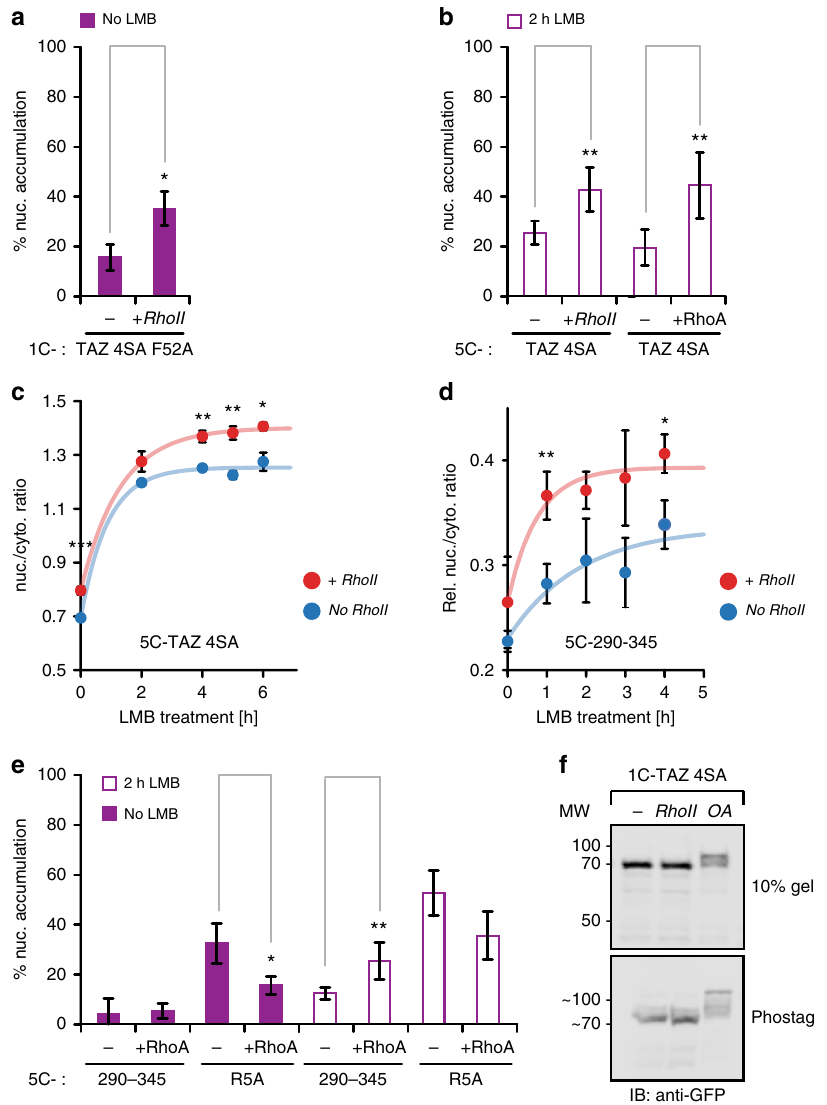
Fig. 6 Regulation of TAZ import by RhoA. a Effect of the RhoA activator RhoII on the nuclear enrichment of 1C-TAZ 4SA F52A (anchorless construct), n = 3. b Nuclear enrichment of 5C-TAZ 4SA upon RhoA activation by RhoII or by co-expression of constitutively active RhoA Q63L along with 2h LMB treatment, n = 6. c RhoA activation increases LMB-induced nuclear accumulation of 5C-TAZ 4SA. LMB time course without and with RhoA stimulation, n = 3. d RhoA activation increase LMB-induced nuclear accumulation of the 5C-TAZ-NLS. LMB time course without and with RhoA stimulation, n = 3. Rel. nuc./cyto. ratio refers to the difference between 5C-TAZ-NLS and 5C. Curves in c and d are fi ts as in Fig. 3c. e RhoA activity selectively increases nuclear accumulation of the TAZ-NLS. 5C-290 – 345 and the SV40-NLS construct 5C-R5A were expressed in combination with control vector or RhoA Q63L. Following a 2 h treatment with or without LMB, nuclear accumulation was visually determined, n = 3, 5, or 6 for individual constructs. f RhoA stimulation does not induce LATS-independent TAZ phosphorylation, as detected by band shifts in western blots. Cells expressing 1C-TAZ 4SA were treated with PBS, RhoII or the phosphatase inhibitor okadaic acid (OA) for 6 h and lysates were run on conventional (upper panel) and Phos-tag (lower panel) polyacrylamide gels. After western blot, ectopic proteins were detected with anti-GFP antibody. Uncropped version shown in Supplementary Figure 6C. Data are represented as means ± SD. * p < 0.05, ** p < 0.01; Student ’ s t